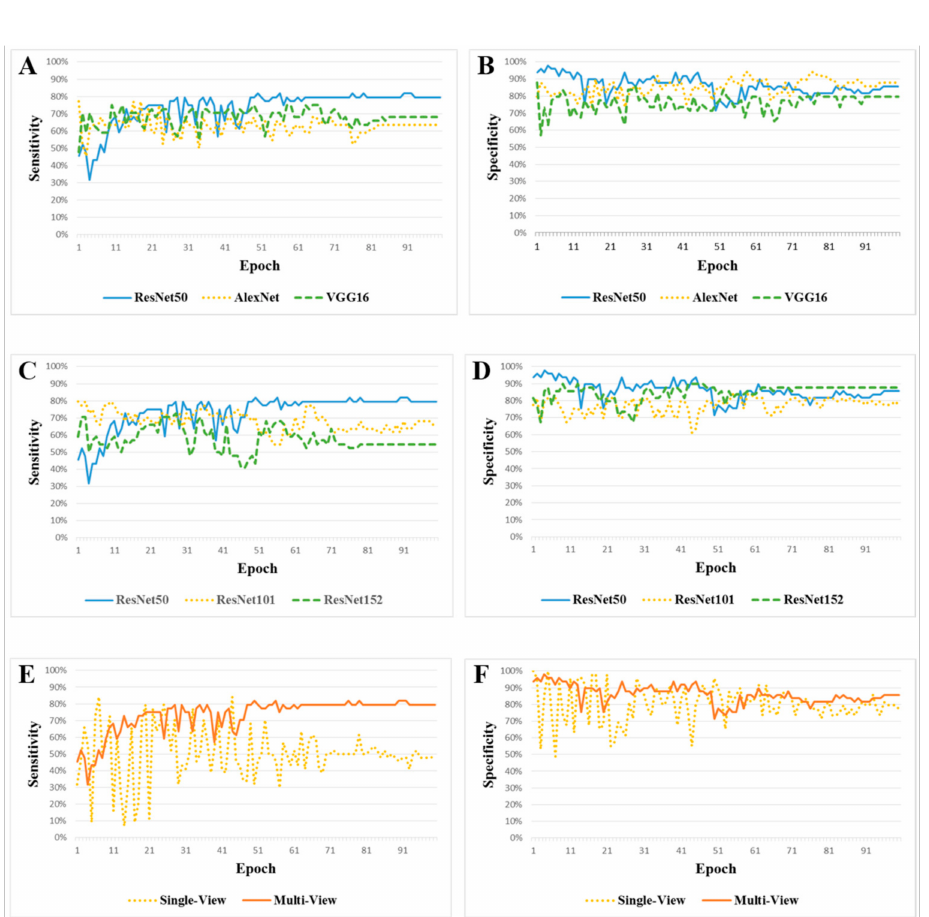
Figure 2. Comparative analyses of multi-view CNN-ResNet50 for predicting rupture risk type involving small UIAs under various conditions: other types of AlexNet and VGG16 ( A , B ), same type but different layers (ResNet101 and ResNet152) ( C , D ), and single-view CNN ( E , F